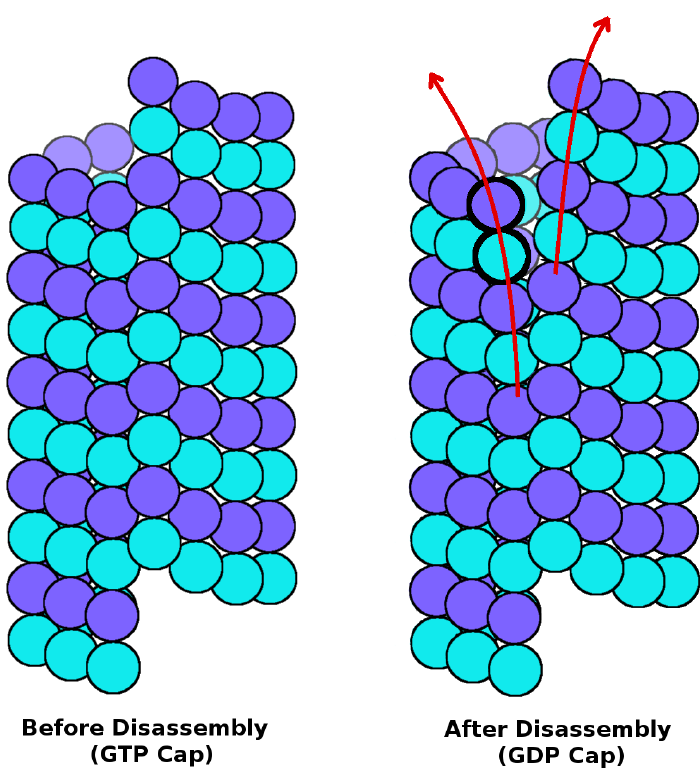
Figure 1. A schematic diagram of microtubule ( left ) before disassembly, where a GTP cap is present, and ( right ) right after the start of disassembly, after GDP hydrolysis and breakdown of lateral contacts at the seam. The plus end is at the top and minus end is at the bottom. β -tubulin is coloured purple and α -tubulin is colored cyan. Red arrows represent the direction of outward curling during